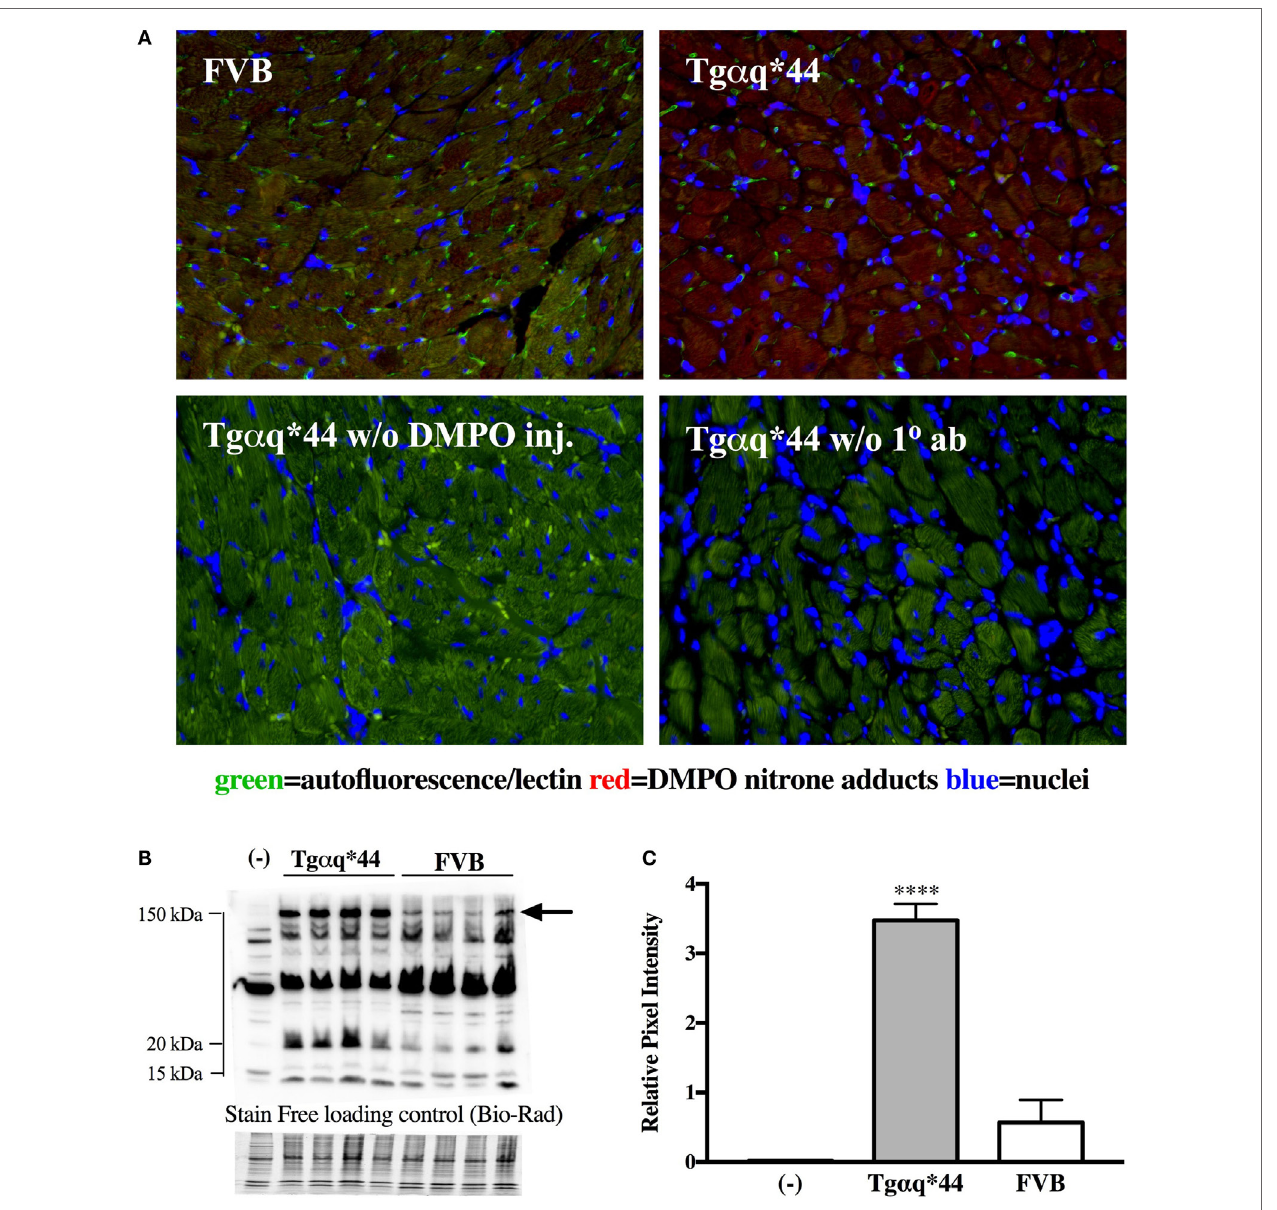
FigUre 1 | DMPO immuno-spin trapping in the myocardium of Tg α q*44 vs FVB mice. (a) Immunohistochemical images of hearts from FVB and Tg α q*44 mice, along with methodological negative controls without DMPO injection (w/o DMPO inj.) or without anti-DMPO primary Ab (w/o 1° ab) (see Materials and Methods